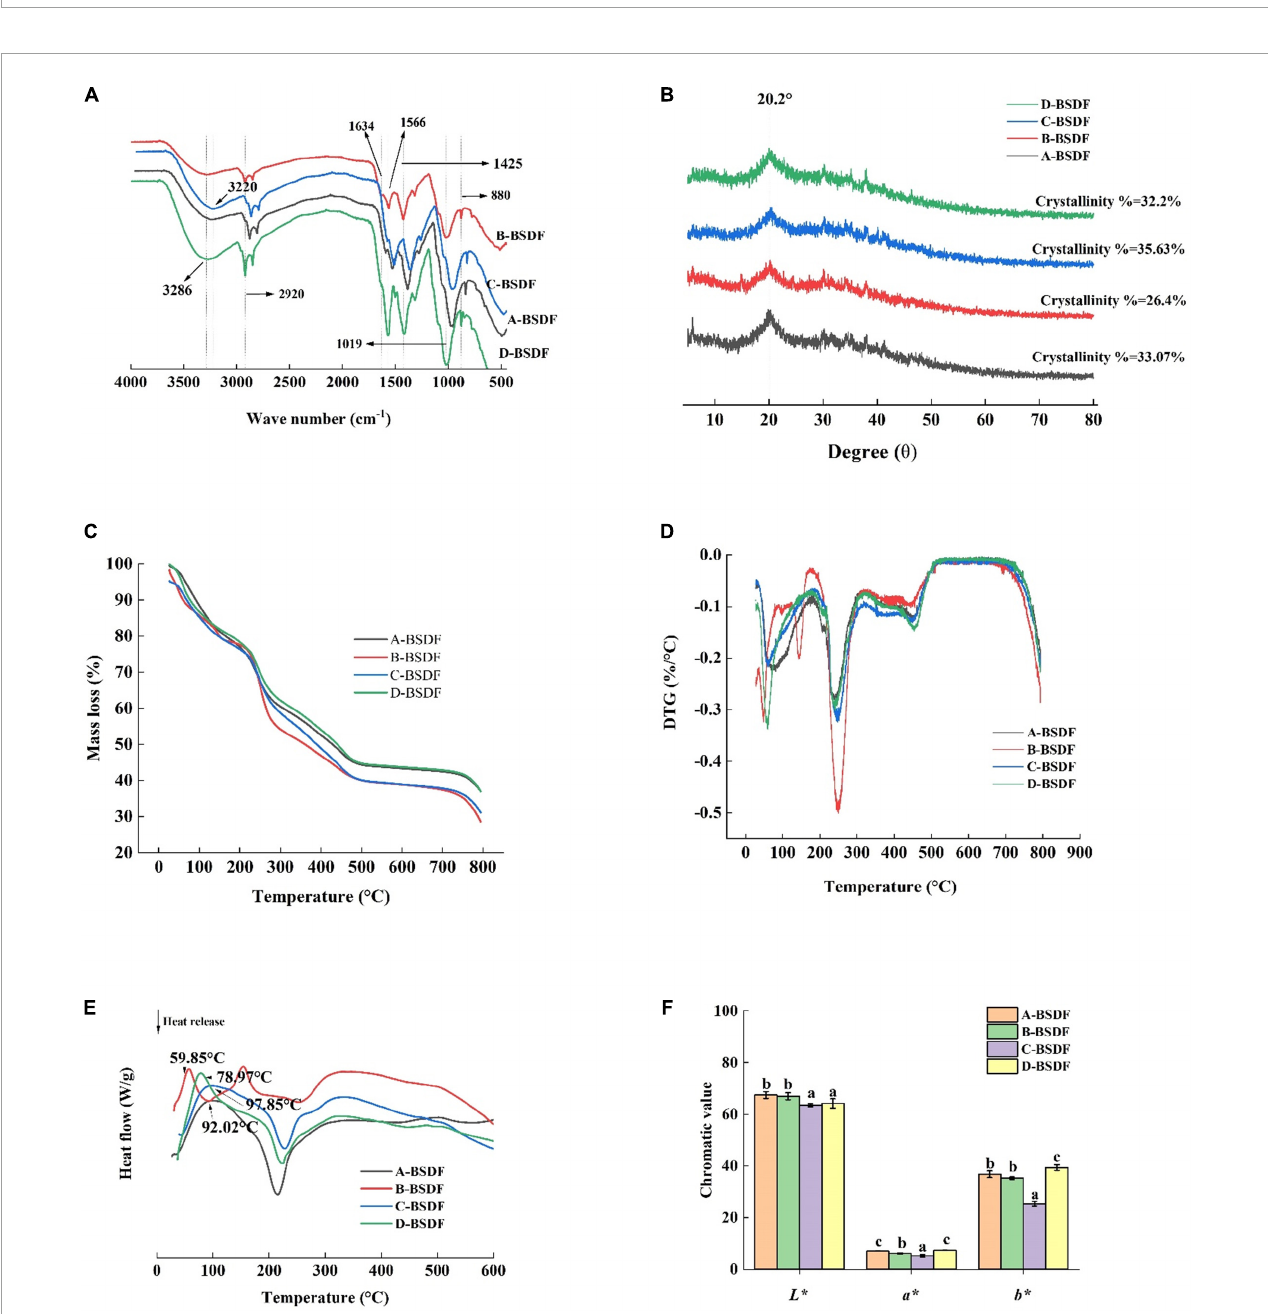
FIGURE4 FT-I R of DF from different bamboo shoots (A) , X-ray diffraction of dietary fiber from different bamboo shoots (B) , TG of DF from different bamboo shoots (C) , DTG of DF from different bamboo shoots (D) , DSC of DF from different bamboo shoots (E) , color index of dietary fiber in different bamboo shoots (F)